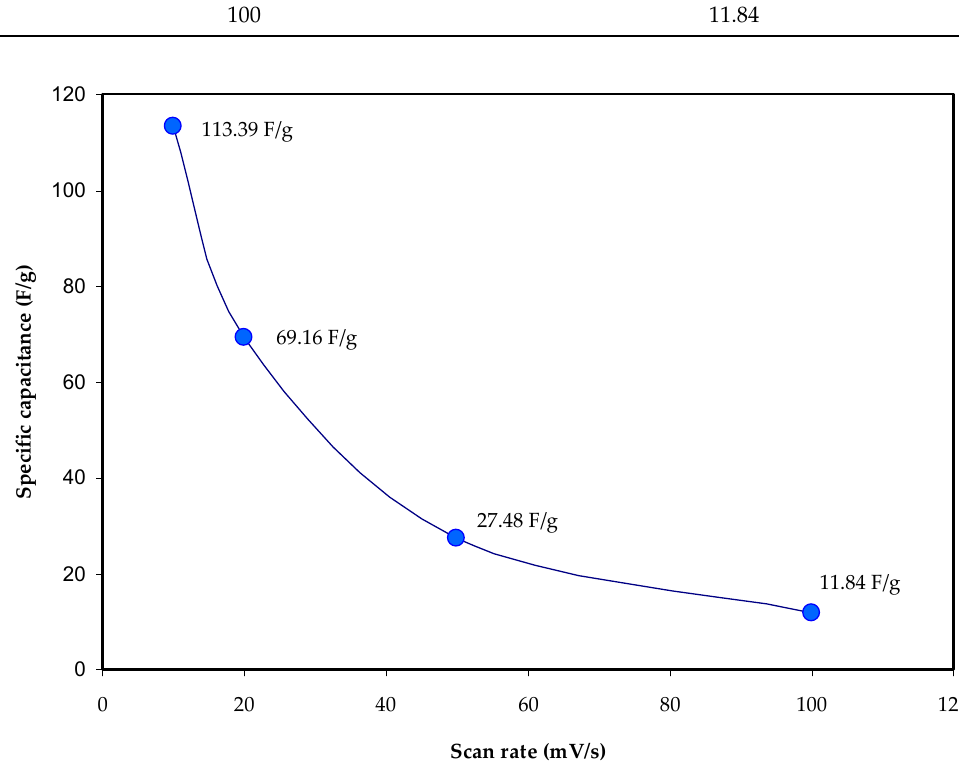
Figure 12. The calculated specific capacitance, C s for the assembled EDLC at a different scan rate. Table 4. Specific capacitance ( C s ) of the EDLCs using different polymer electrolytes at room temper-